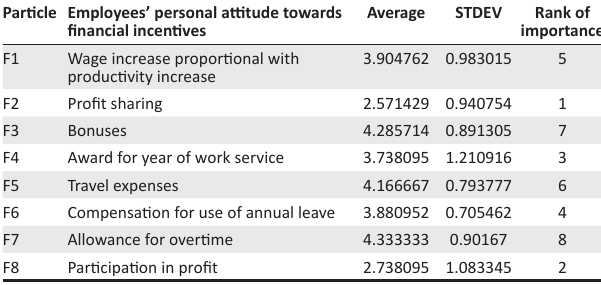
Table 5: Employees’ attitude towards financial incentives.